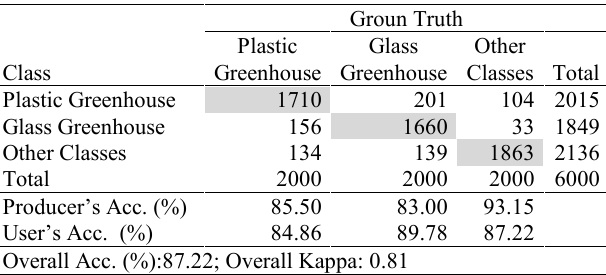
Table 2. The confusion matrix of RF classification result